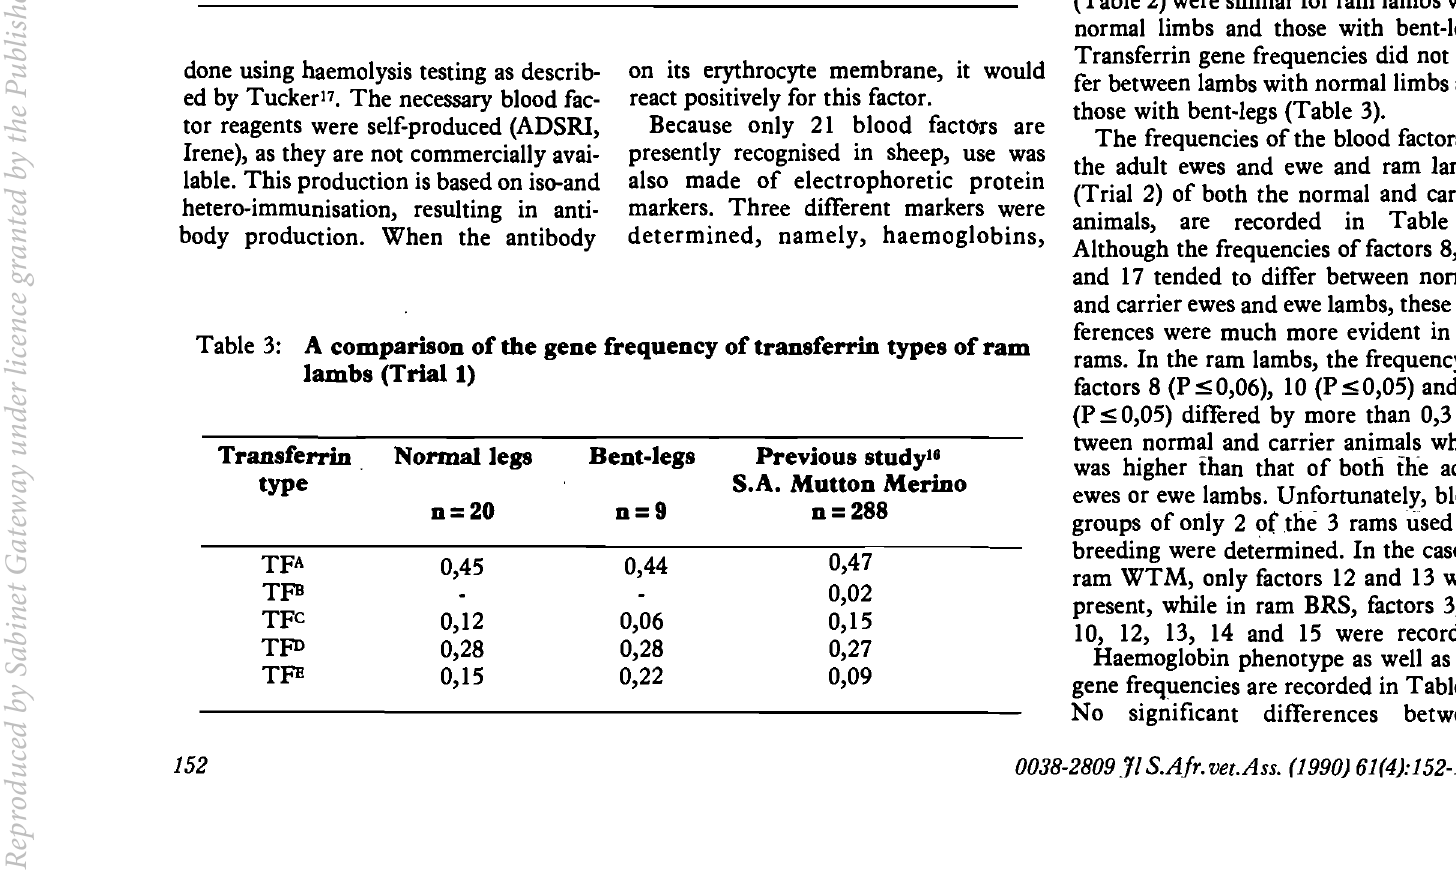
Table 2: The hae~oglobin phenotypic distribution and gene frequency of